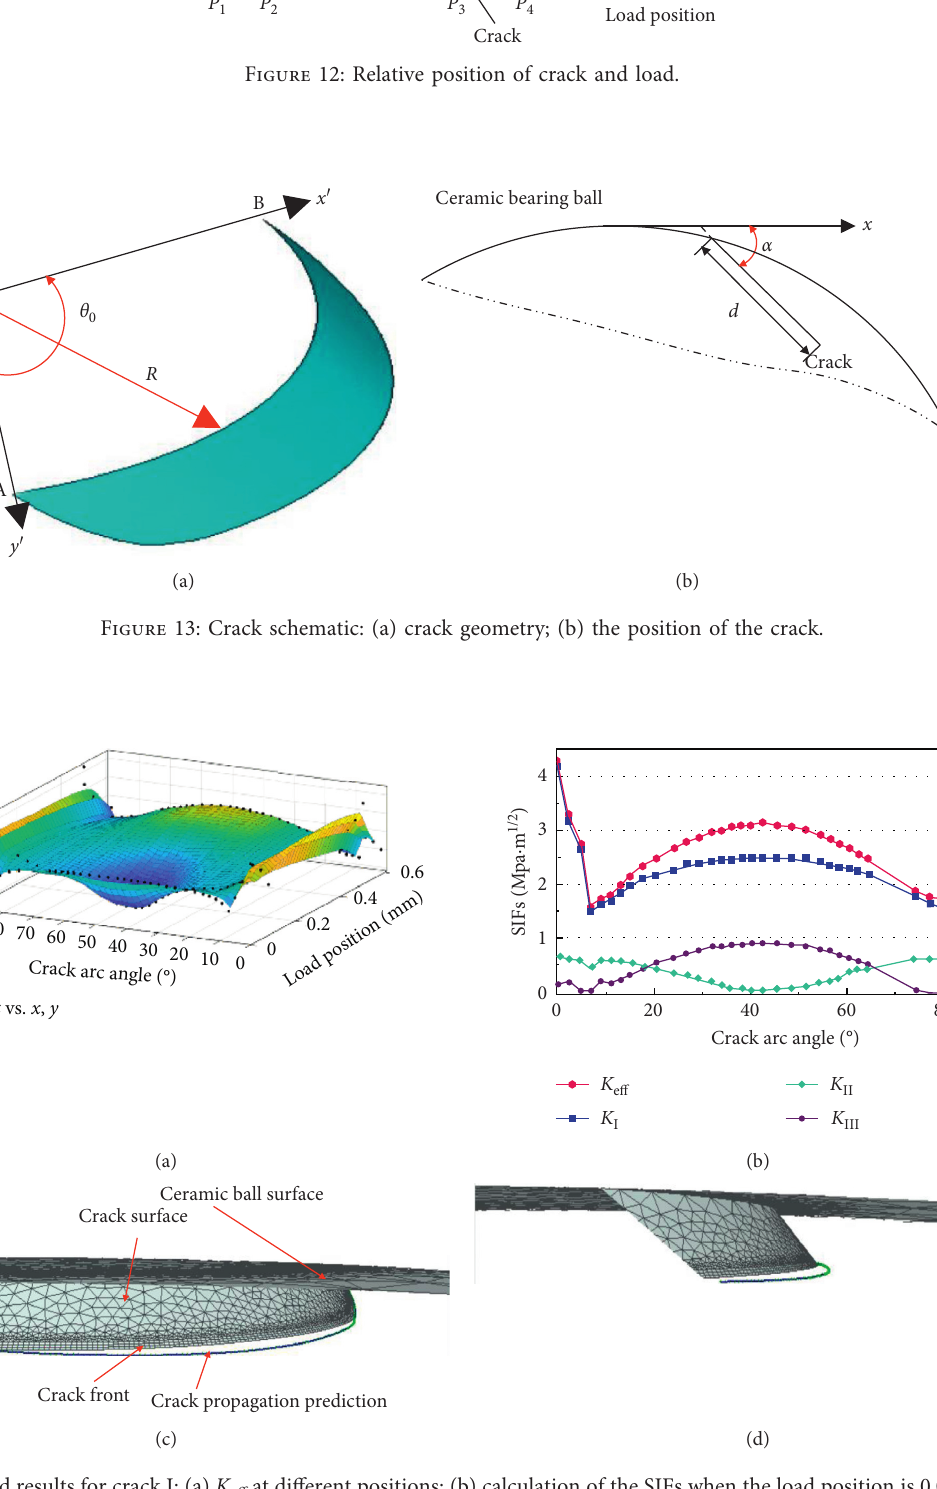
Figure 14: Related results for crack I: (a) K eff at different positions; (b) calculation of the SIFs when the load position is 0.08mm; (c) front view of crack propagation; (d) side view of crack